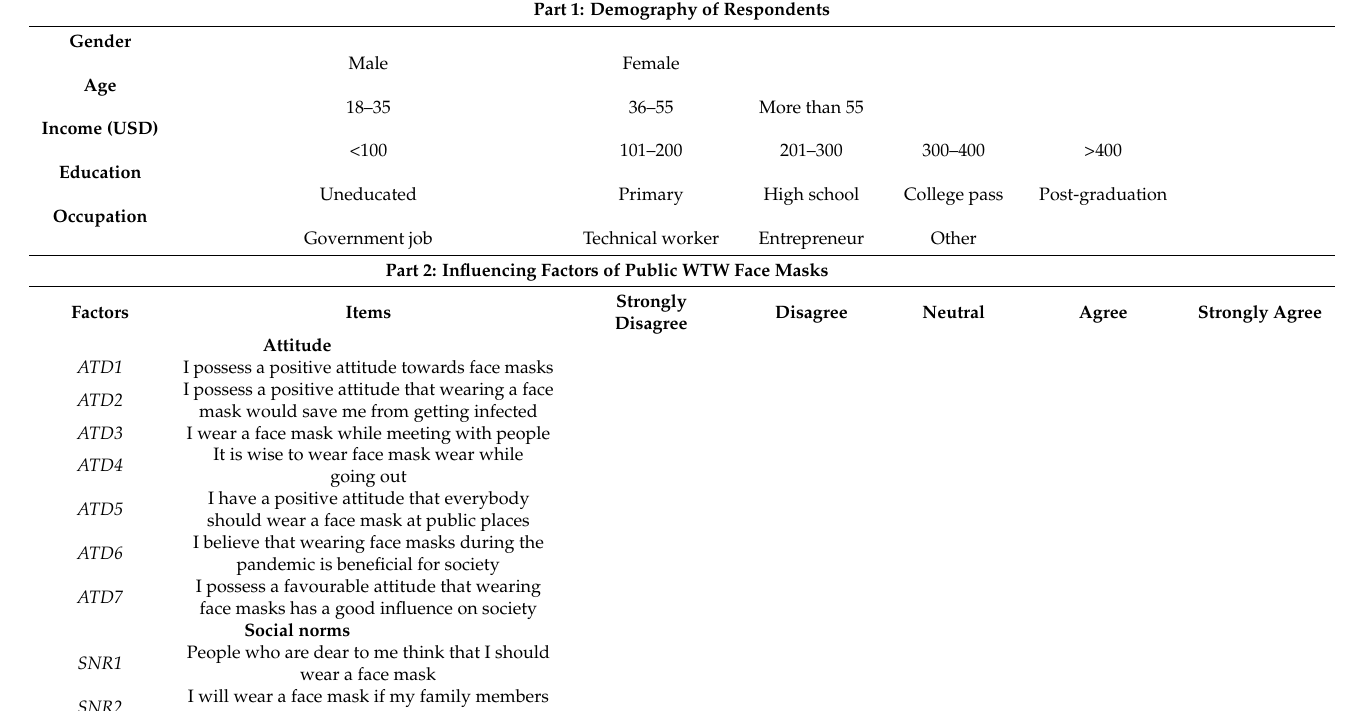
Table A1. Questionnaire